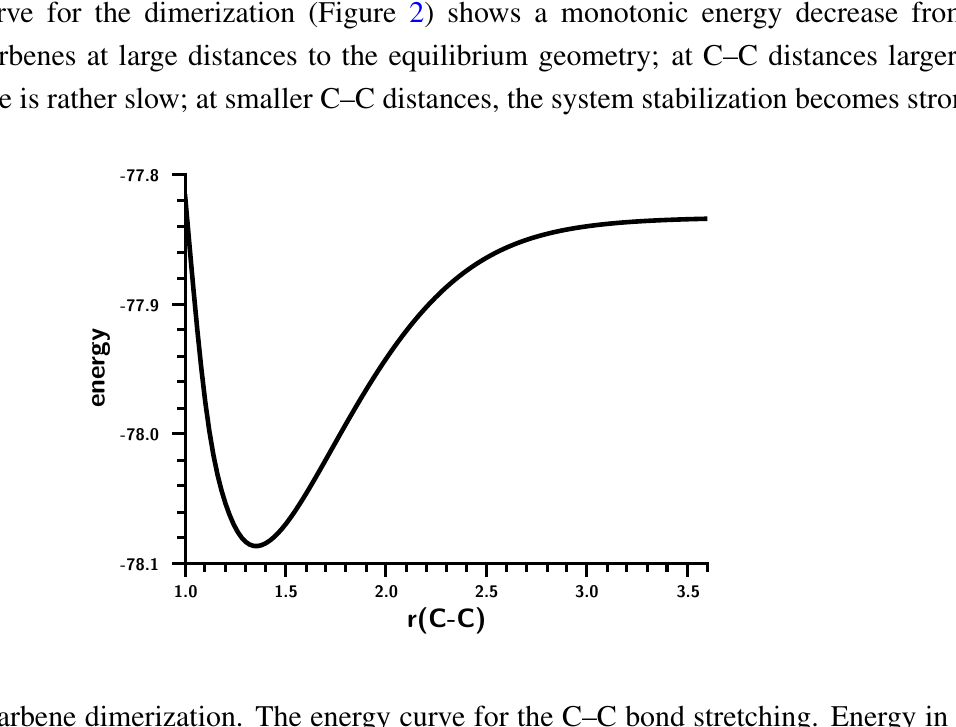
Figure 2. Carbene dimerization. The energy curve for the C–C bond stretching. Energy in Hartrees; bond length in